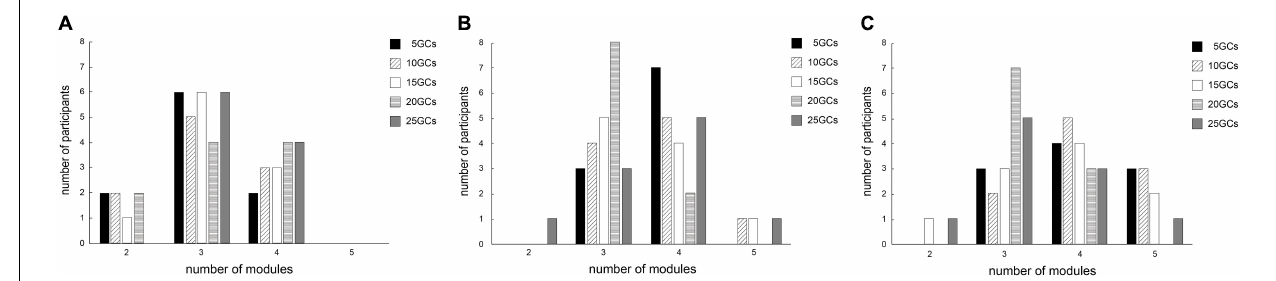
FIGURE 2 | The effects of different conditions on the number of extracted modules by NNMF. The effects of different GCs when the LPFs were 4 Hz (A) , 10 Hz (B) , and 15 Hz (C) . NNMF, non-negative matrix factorization; LPF, low-pass filter; GC, gait cycle.